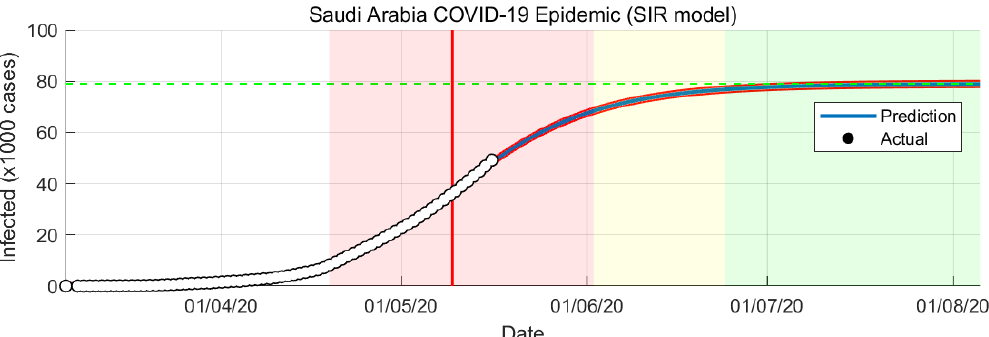
Figure 5. COVID-19 epidemic in Saudi Arabia prediction based on SIR model.